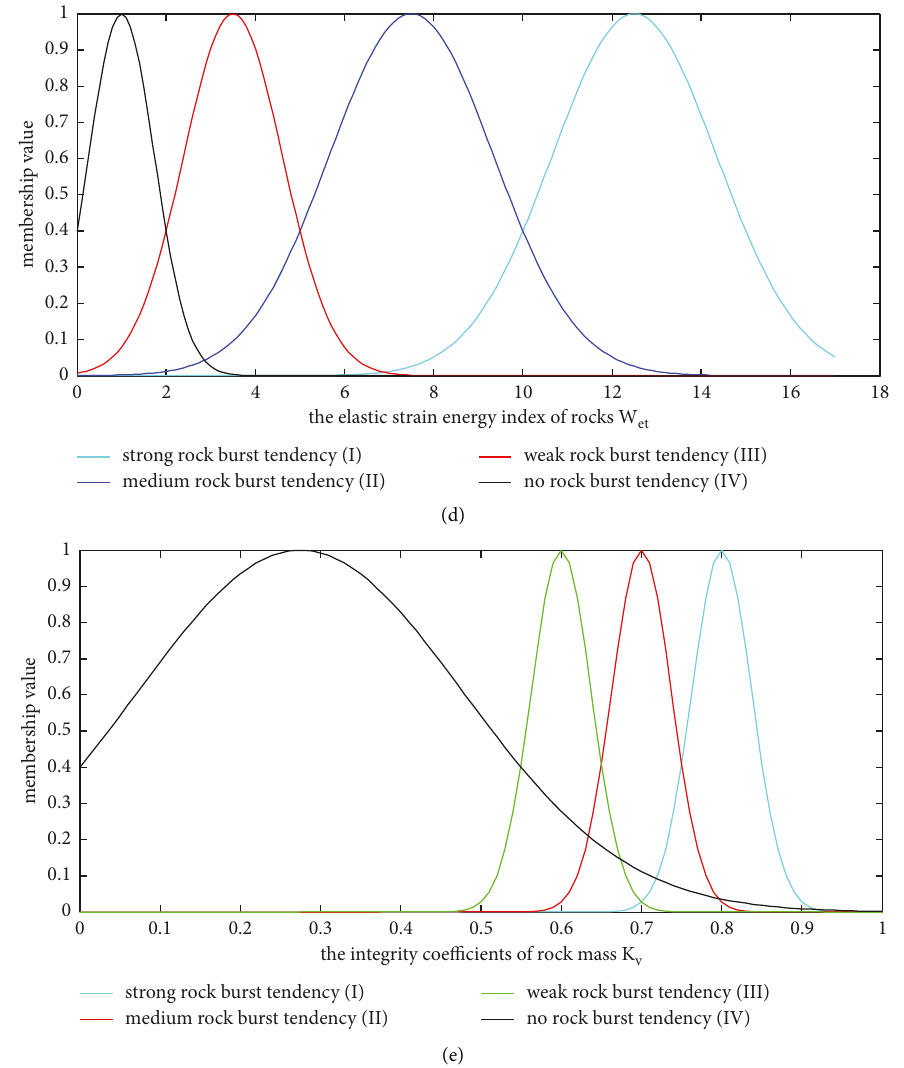
c , (b) strength stress ratio σ c / σ 1 , (c) ratio of